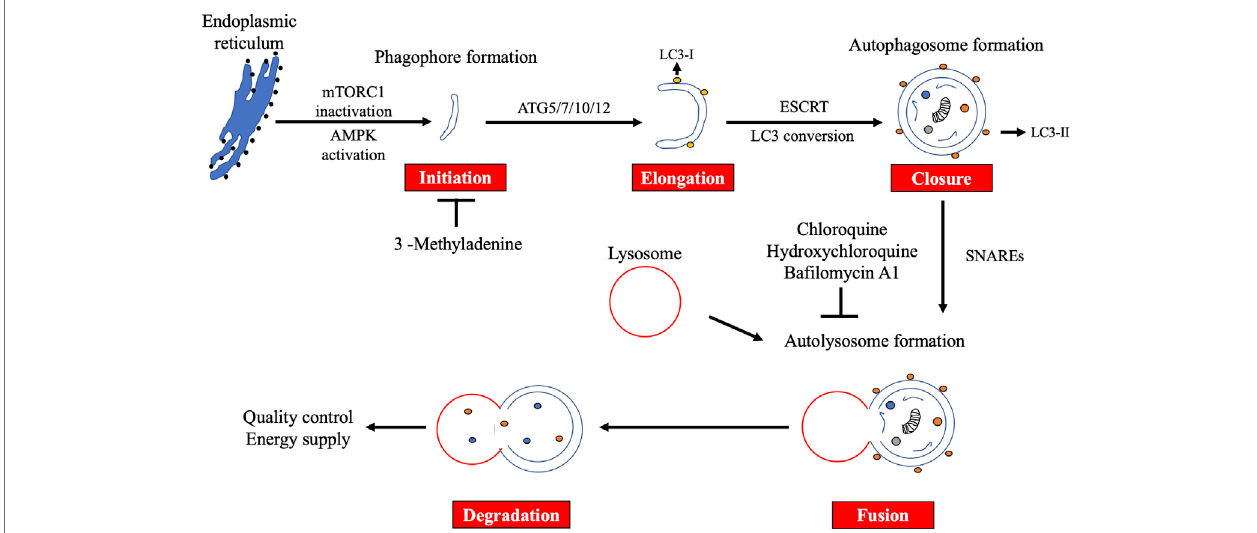
FIGURE 1 | Overview of macroautophagy. Macroautophagy (autophagy) consists of fi ve steps: initiation, elongation, closure, fusion, and degradation. Autophagy plays an important role in quality control and energy supply. 3-Methyladenine suppresses the initiation step, whereas chloroquine, hydroxychloroquine, and ba fi lomycin A1 block the fusion